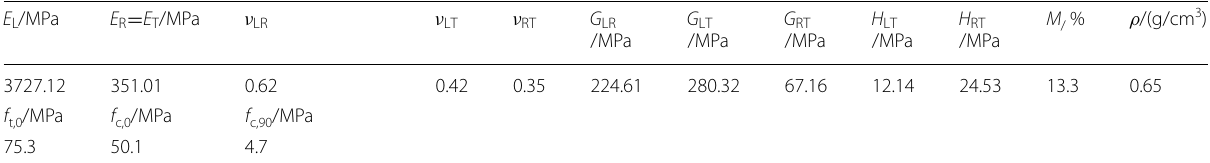
Six samples were utilized for each test. E L , E R , E T are the elastic modulus in longitudinal, radial, and tangential directions, respectively; G LR , G LT , G RT are the shear modulus under different directions; ν is the Poisson’s ratio under different directions; M represents the moisture content; ρ is the density of wood; f t,0 and f c,0 are the tension and compression strength parallel to grain, respectively; f c,90 stands for the compression strength perpendicular to grain.